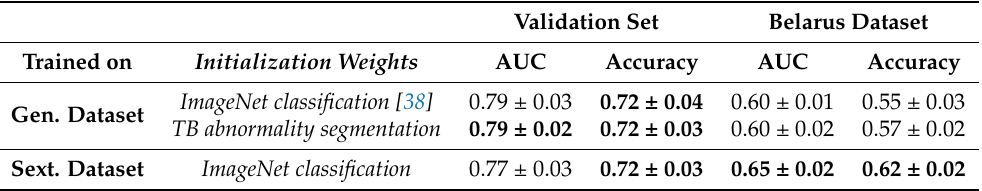
Table 3. DR-TB/DS-TB Classification Performance on the Validation Set and the Belarus Set.